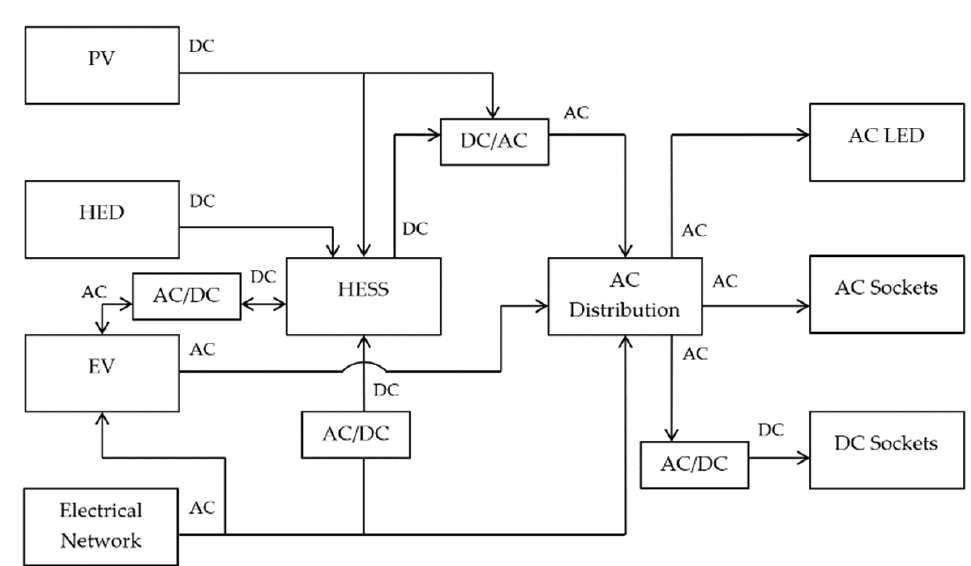
Figure 9. Block diagram of the socket rectification scenario with PV, HED, and EV.